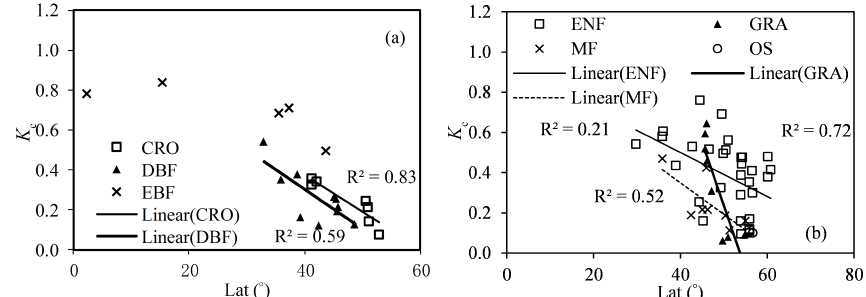
Figure 5. Variation of annual K c at different latitudes (lat): (a) cropland (CRO), deciduous broad leaf forest (DBF), and evergreen broad leaf forest (EBF); (b) evergreen needle leaf forest (ENF), grassland (GRA), mixed forest (MF), and open shrubland (OS). The absolute values of the latitude were used in EBF for sites in the Southern Hemisphere, and all the determination coefficients ( R 2 ) listed in the figure were significant ( p